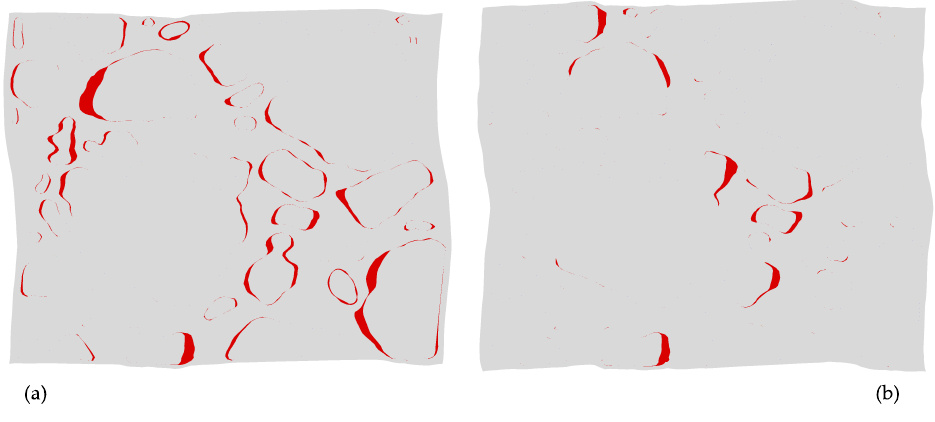
Figure 11. Void growth patterns at 5% macroscale strain using a polycrystalline mesh identical to those depicted in Figures 9 and 10 for material parameters mimicking ( a ) sample CF75H and ( b ) sample CF75L . The red fill indicates the region of void growth associated with crystal-binder